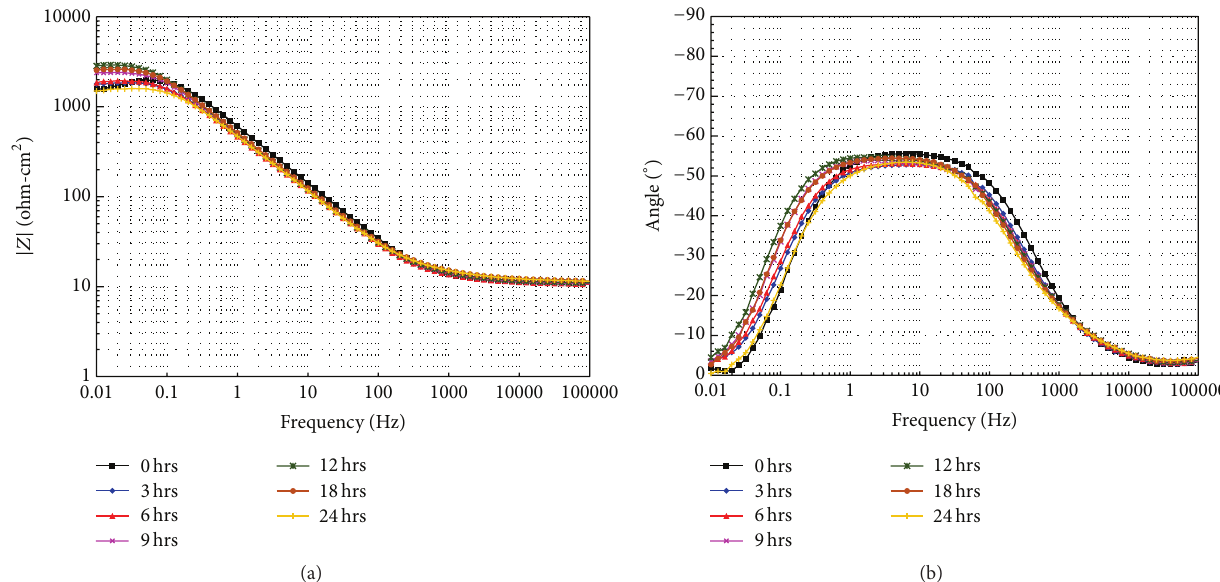
Figure 11: Bode plots for 30Nd8Pr magnet tested in 3.5% NaCl solution at 25 ∘ C for 24